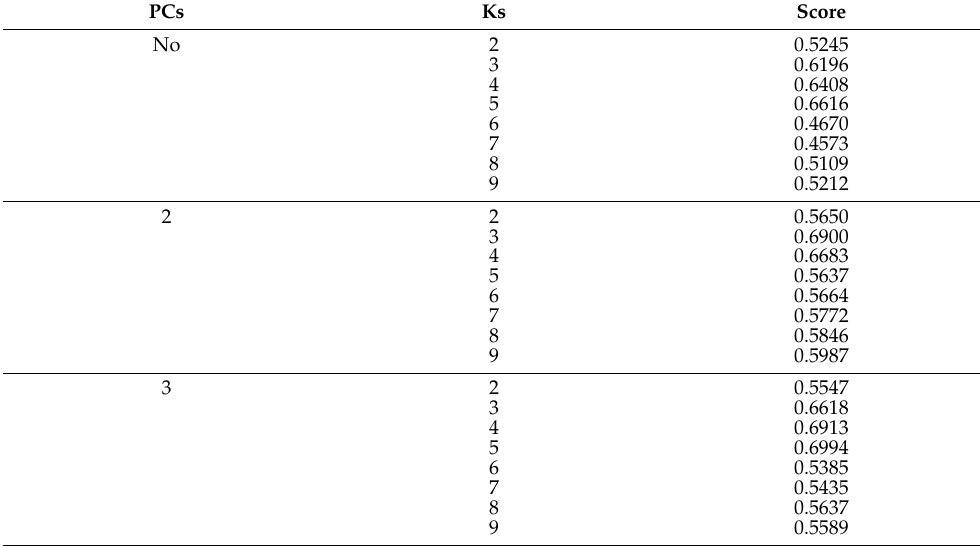
Table A1. Silhouette scores values for every pair of pipeline parameters obtained through the grid-search